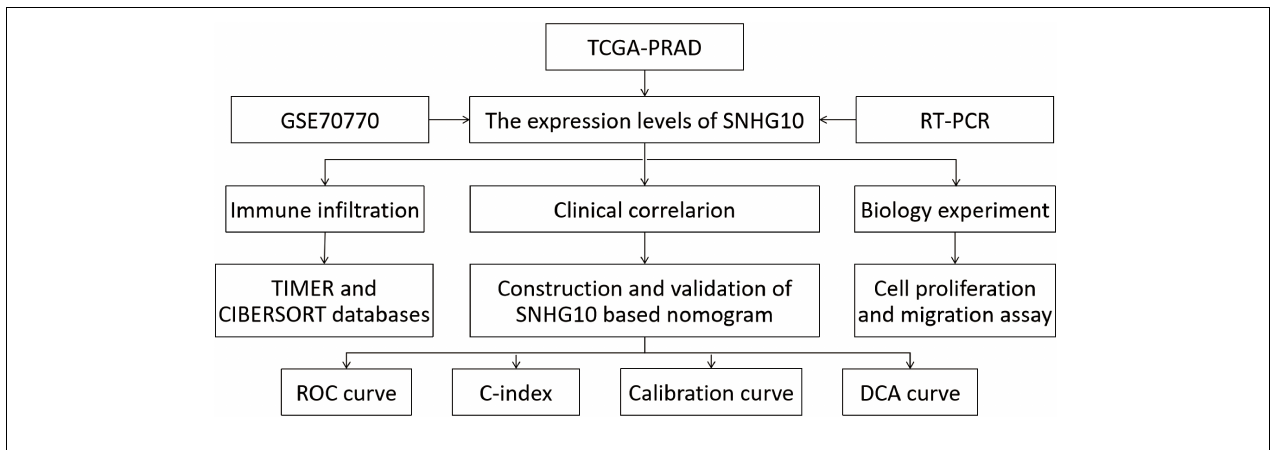
FIGURE 1 | The workflow of this study.